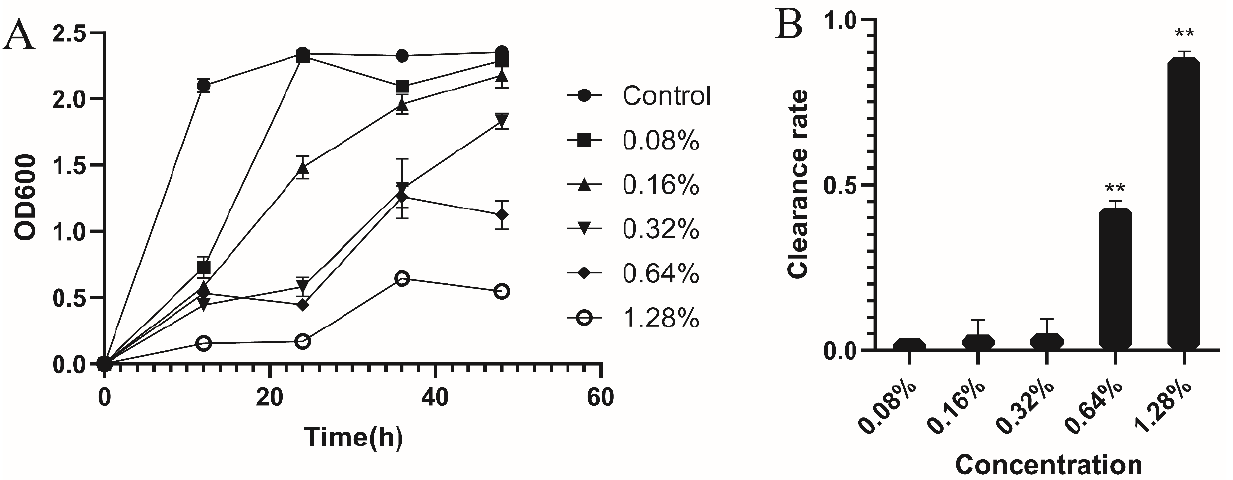
Figure 2. Impact of CEO on MRSA biofilm. ( A ): Effect of CEO on the formation of MRSA biofilms; the ordinate represents the relative content of MRSA biofilms. ( B ): Disruption of mature biofilms; the ordinate represents the clearance rate of MRSA biofilm by CEO. ** p < 0.05.